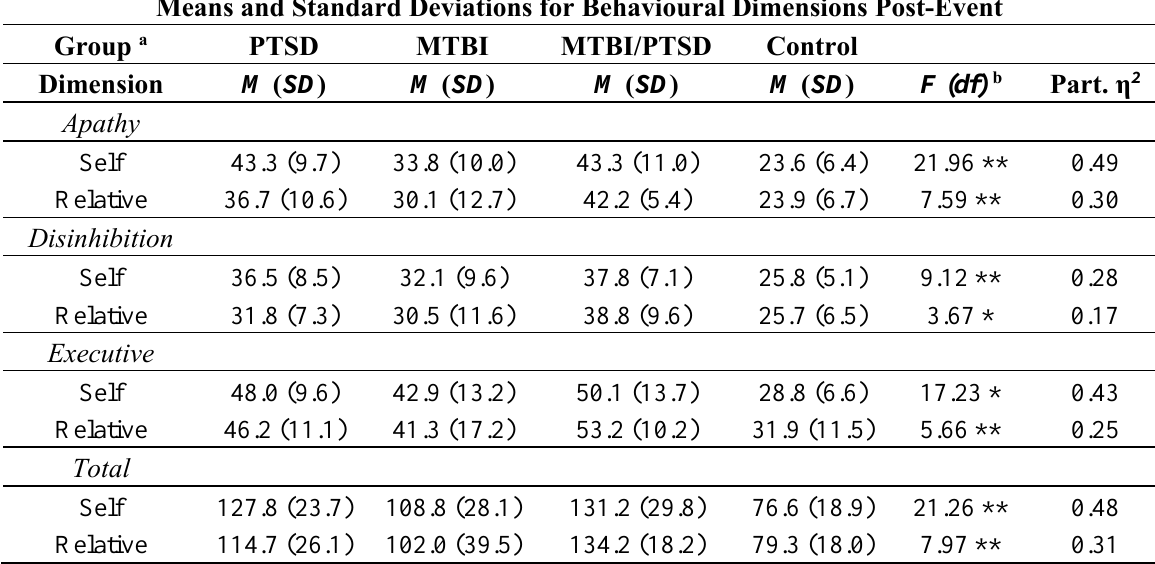
Figure 1. Example of most frequent responses to Cognitive Failure Questionnaire (CFQ) (“often” and “very often”). Table 2. Participants’ self and relatives’ Frontal Systems Behavior Scale (FrSbe)